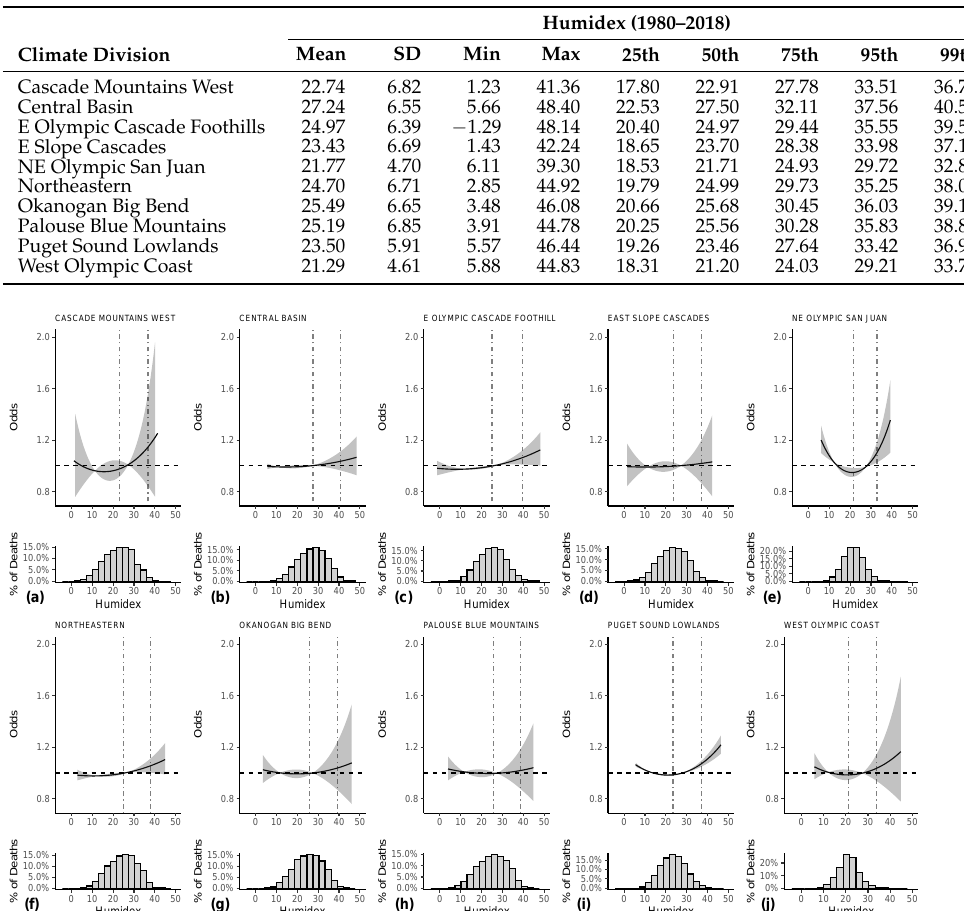
Table 2. Historical humidex descriptive statistics.